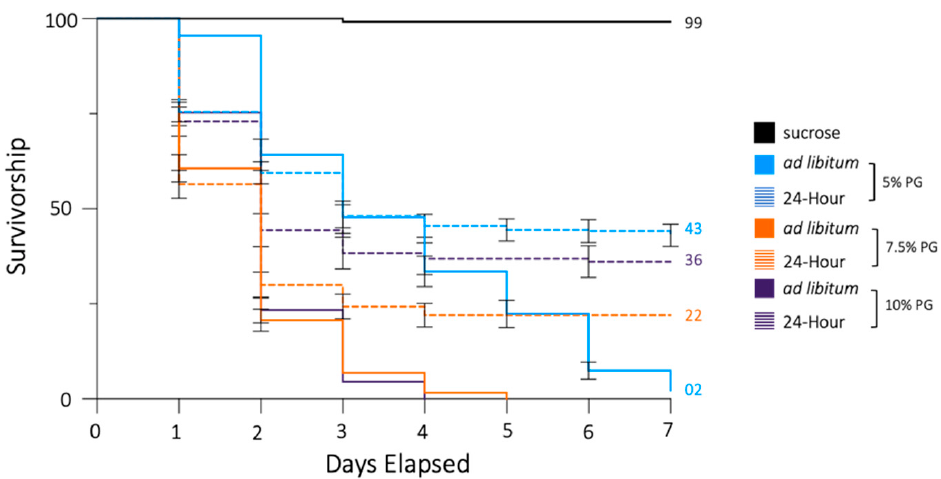
Figure 1. Propylene glycol reduces the daily survivorship of Ae. aegypti mosquitoes. Day 0 indicates the day propylene glycol solutions were added. A Kaplan–Meier curve demonstrates the decline in mosquito survivorship over the course of 7 days. Populations fed on sucrose, sucrose + 5% propylene glycol, sucrose + 7.5% propylene glycol, or sucrose + 10% propylene glycol ad libitum or for a 24 h period, at which point the propylene glycol solutions were replaced with 5% sucrose. Percentage of the population surviving at day 7 is provided when applicable. Error bars indicate SE of the mean.